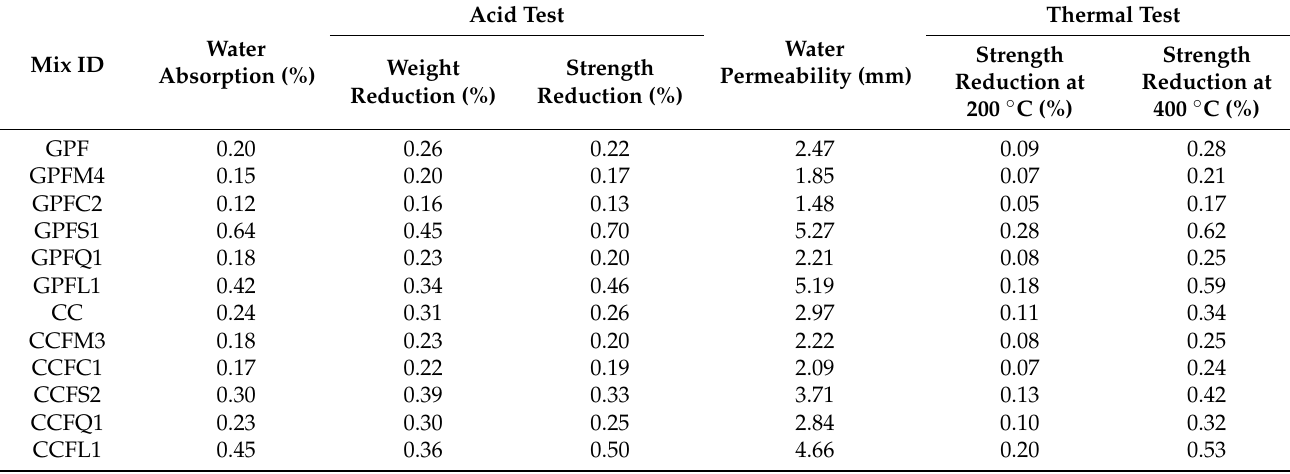
Table 7. Durability test results for geopolymer concrete and cement concrete